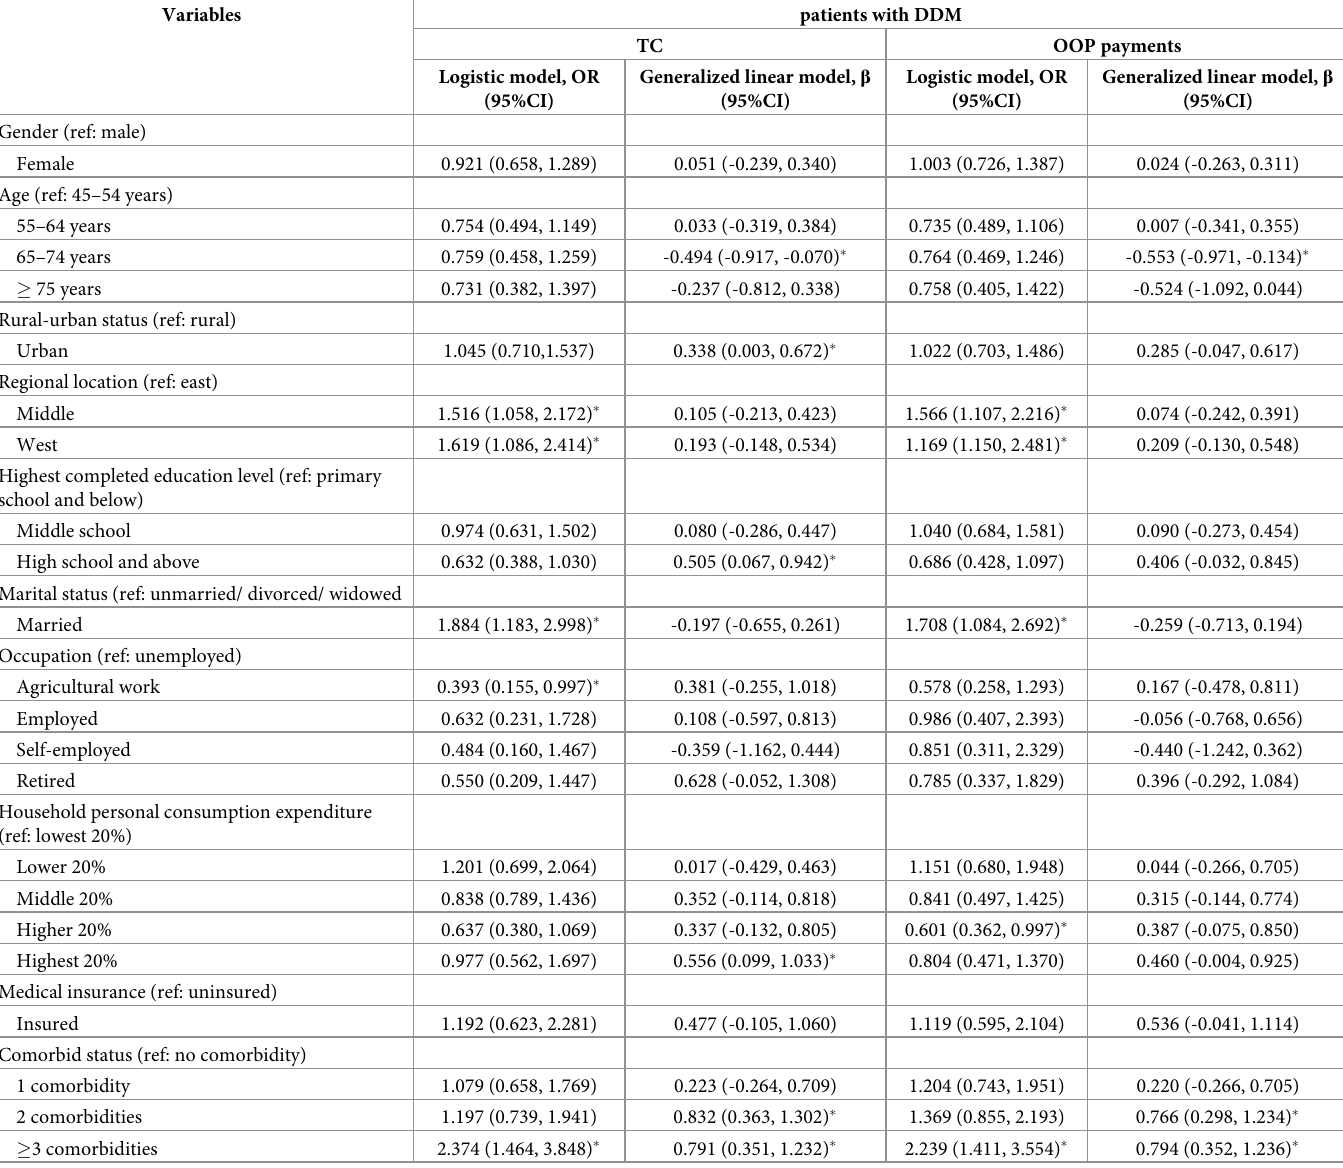
Table 4. Association between social determinants and TC and OOP in the population with DDM in the CHARLS 2011 study.